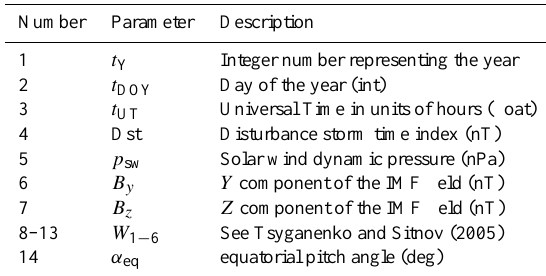
Table 2. Input parameters for the neural network LANLmax .